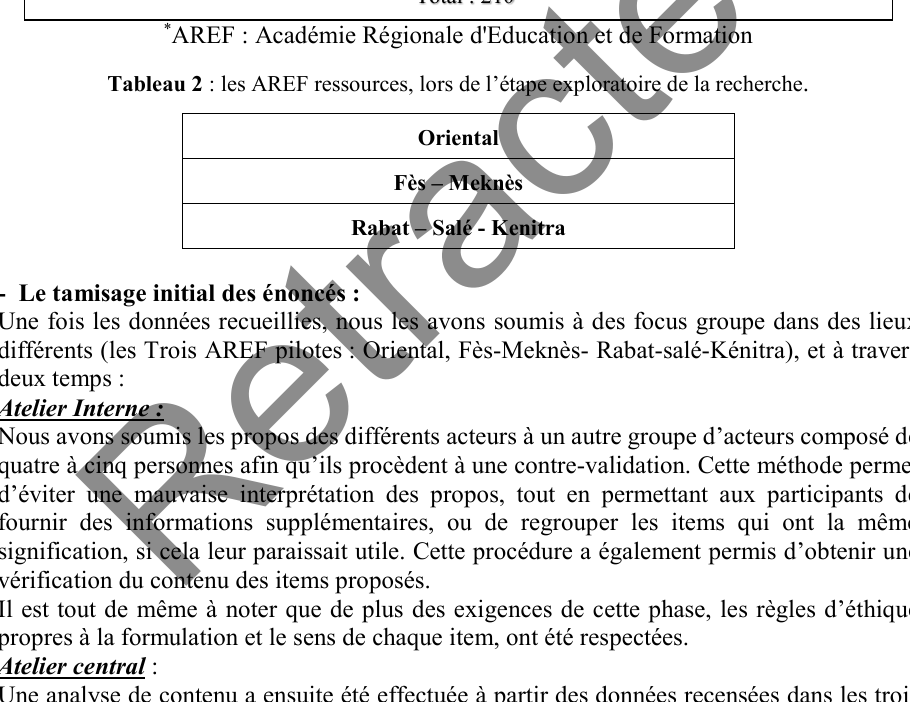
Figure 2 : Recueil des données qualitatives.